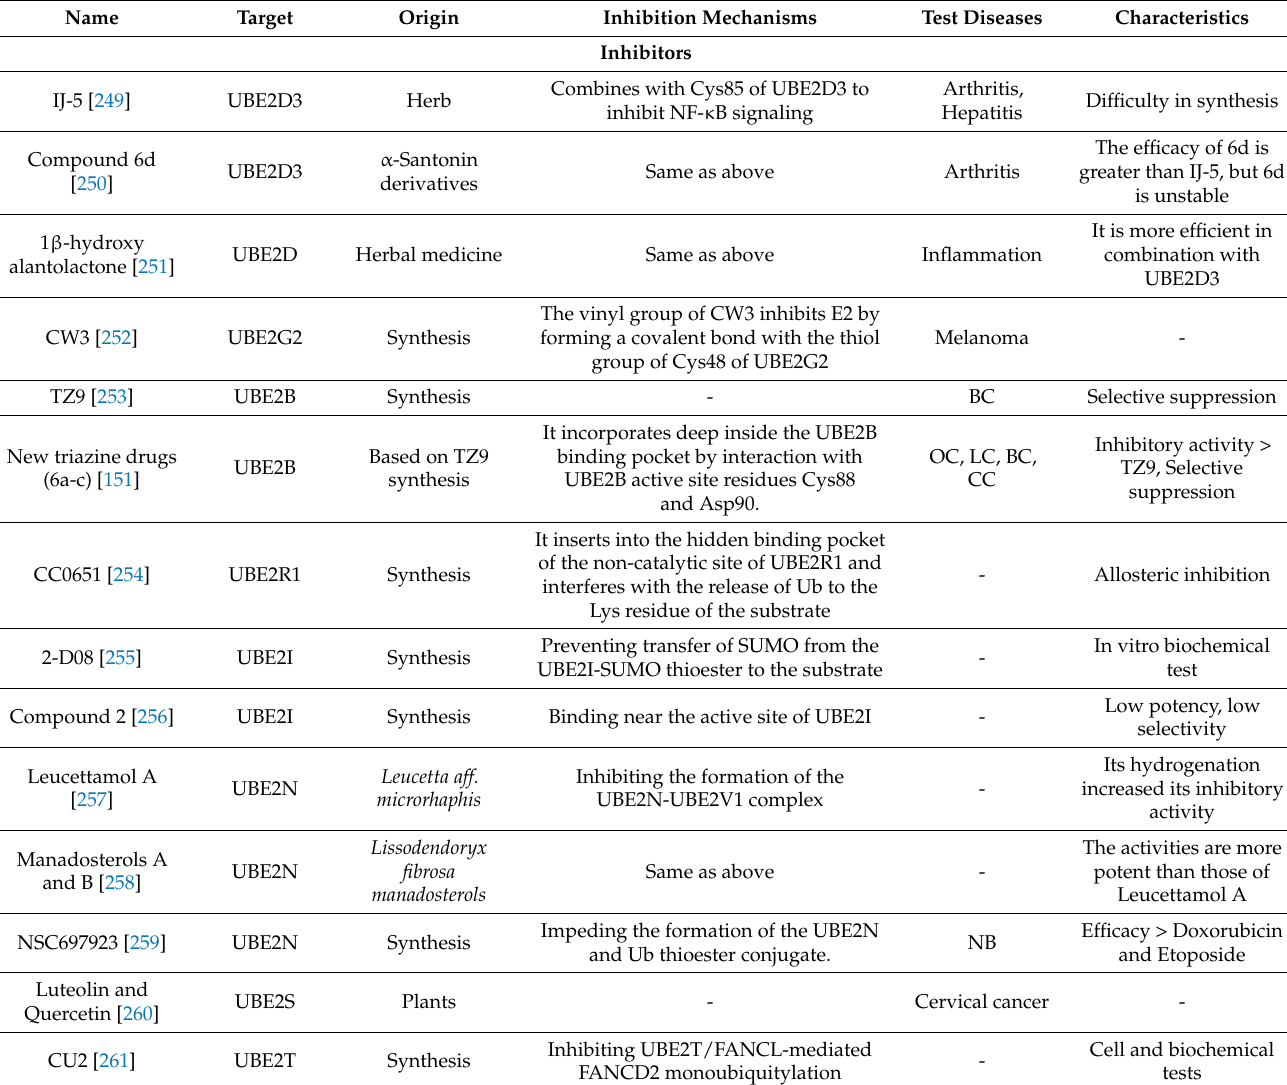
Table 2. Inhibitors and miRNAs targeting